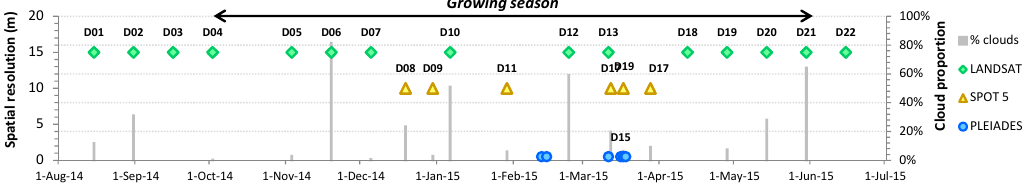
Figure 2. Chronogram of the 2014–2015 satellite acquisitions. The cloud percentage represents the proportion of clouds over polygons of the ground database for each acquisition date. For the PLEIADES coverage, 16th March 2015 (D15 for date 15 of the time series) was chosen to represent the median acquisition date of the different tiles.